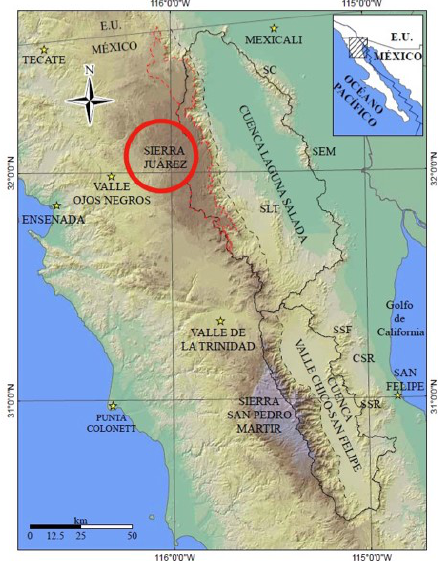
Figure 4. Sierra Juarez-Constitution National Park (marked by red circle ), Ensenada, BC, México.